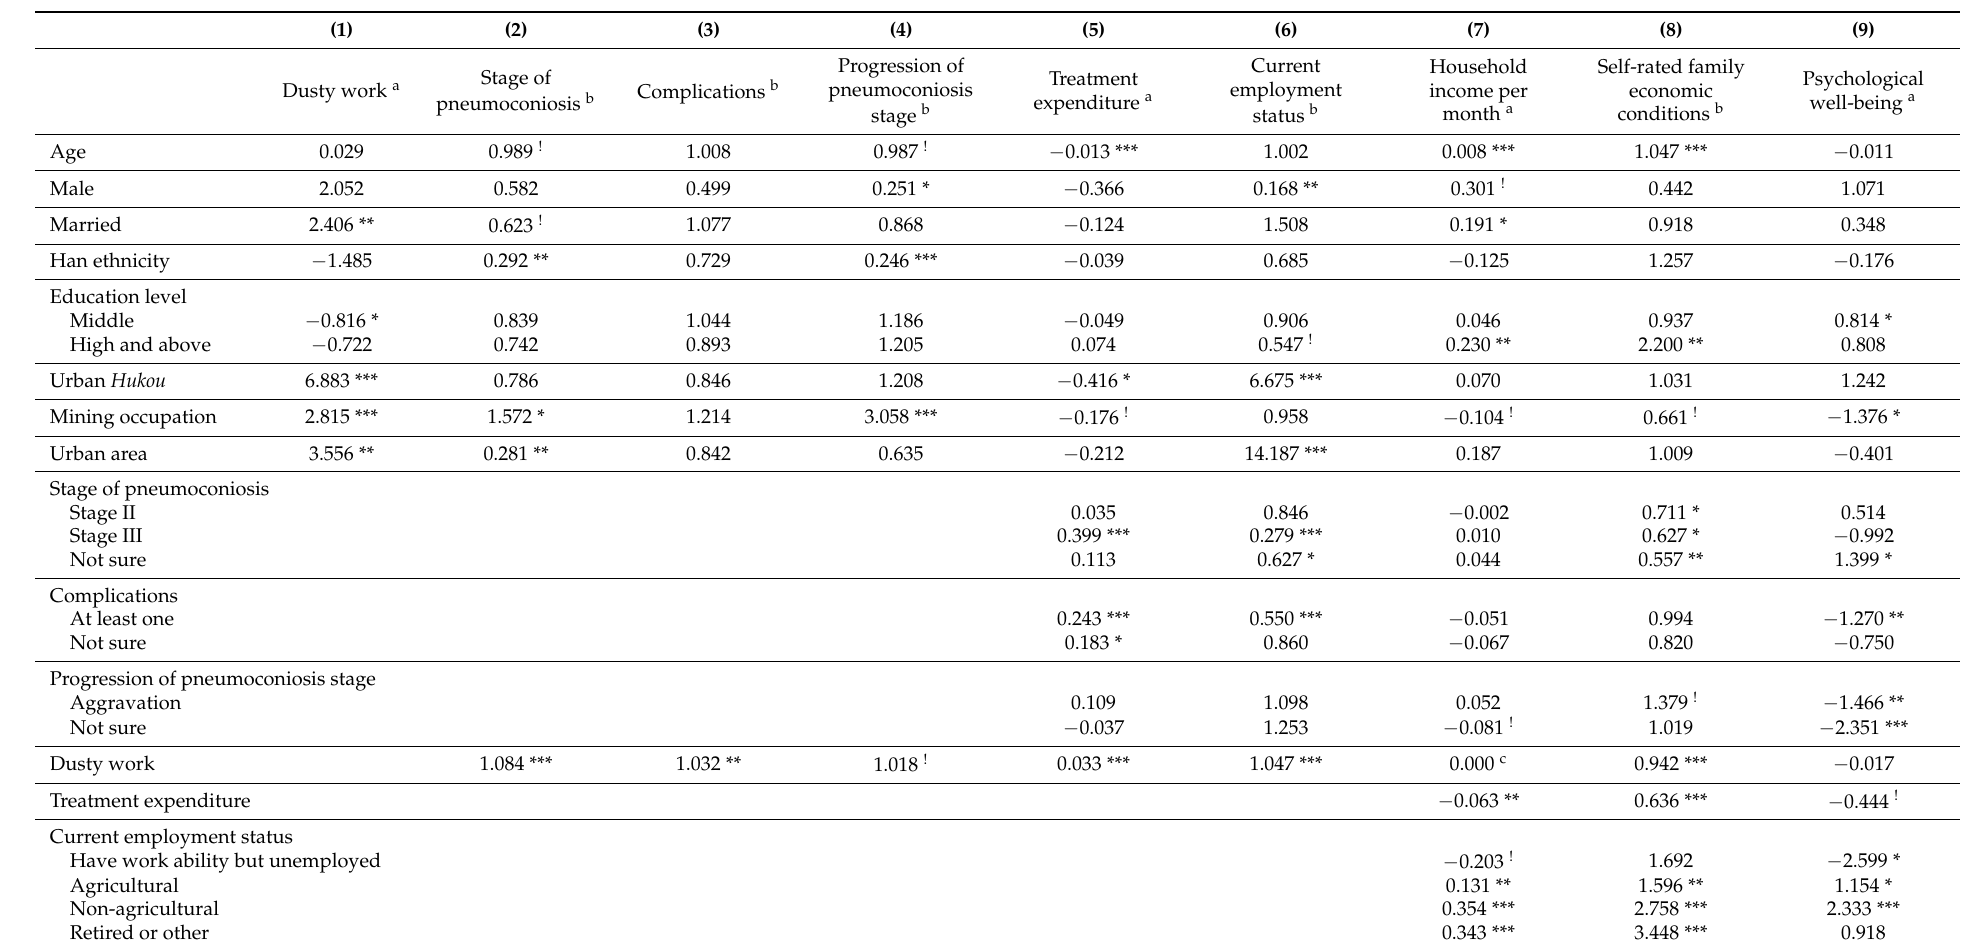
Table 2. Results of the Examined Direct Links Using GSEM Analysis ( N =